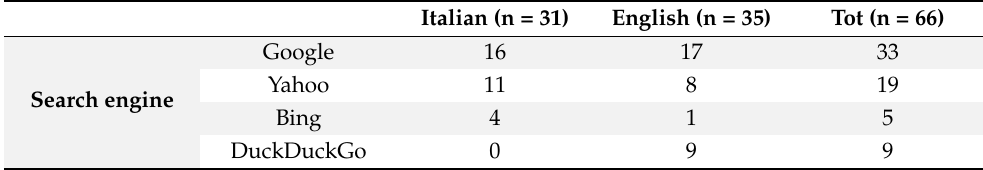
Table 1. Distribution of elected web sites by search